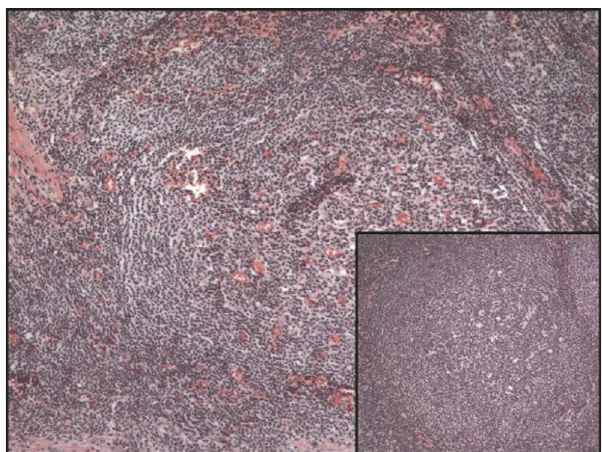
Figure 1: Right-sided dominant thyroid nodule seen on thyroid ultrasonography. Figure 2: Mantle cell lymphoma involving the thyroid and prela-